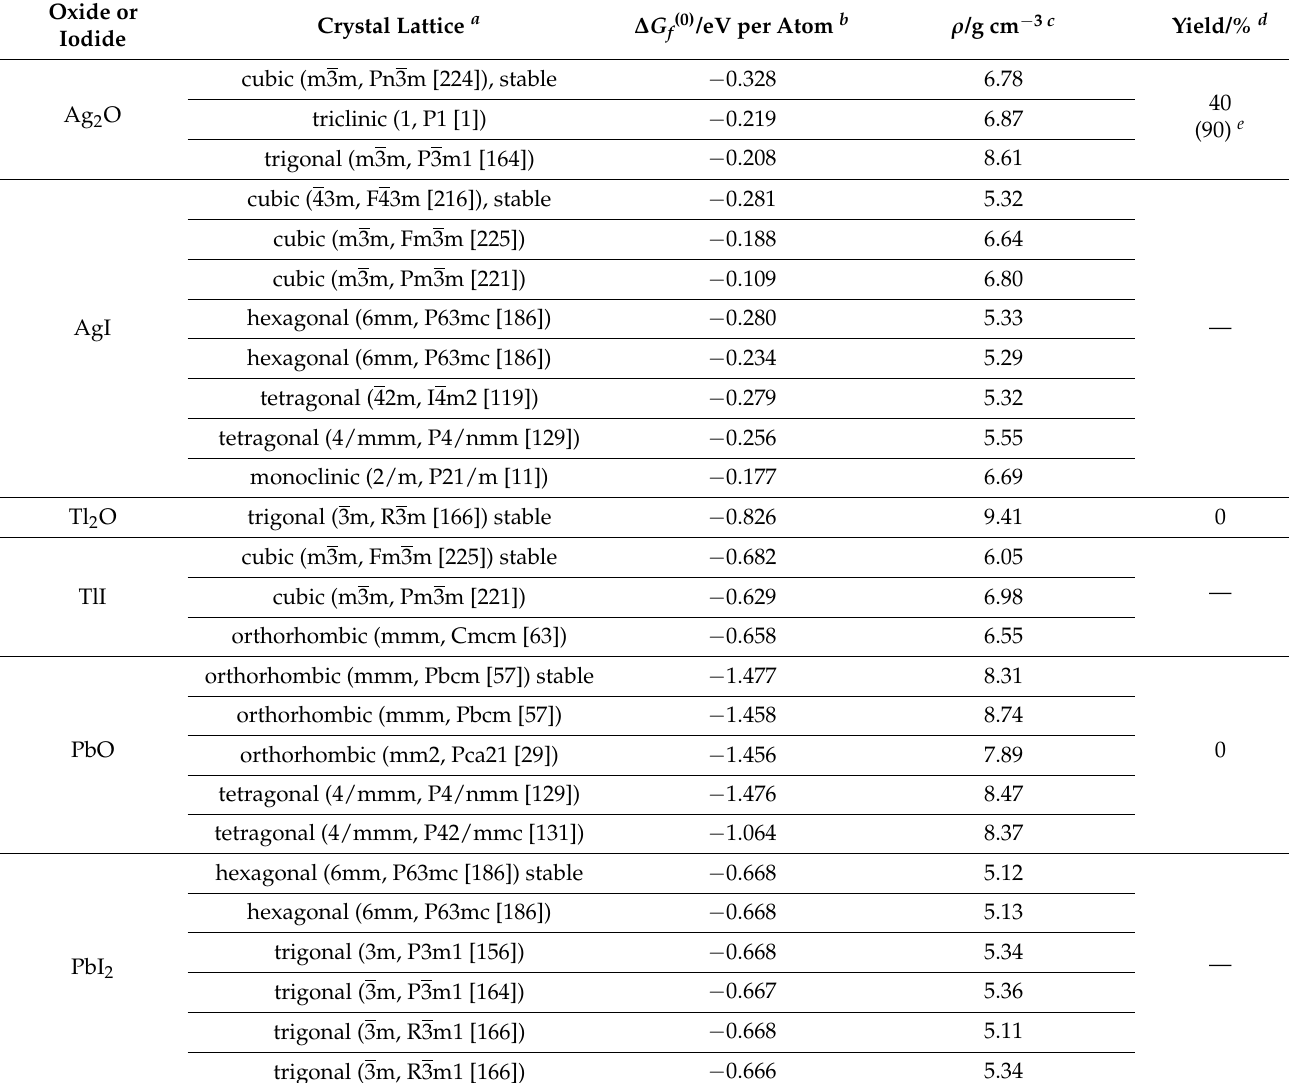
Table 2. Characteristics of the oxides and iodides of silver(I), thallium(I), and lead(II) [79]. Oxide